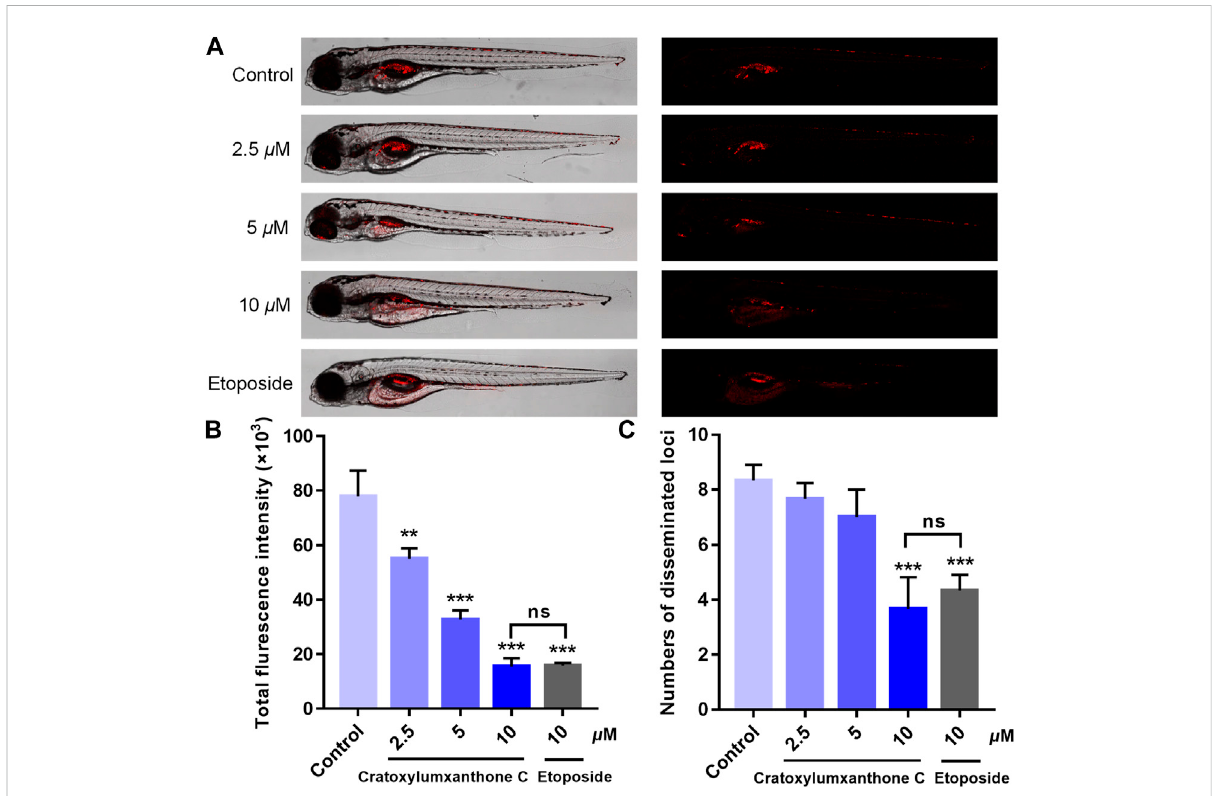
FIGURE 8 Cratoxylumxanthone C inhibited proliferation and migration of A549 cells in zebra fi sh xenografts. CM-DiI stained A549 cells were microinjected into 2 dpf zebra fi sh embryos. After 4 h, tumor-bearing embryos were treated with cratoxylumxanthone C (2.5, 5, and 10 μ M) and the positive control, etoposide (10 μ M) for 48 h ( n = 15/group). (A) Intensity and distribution of the red fl uorescence were imaged under a confocal microscope of disseminated foci in zebra fi sh. (B) The proliferation was quanti fi ed by ImageJ software. (C) The metastasis of A549 cells